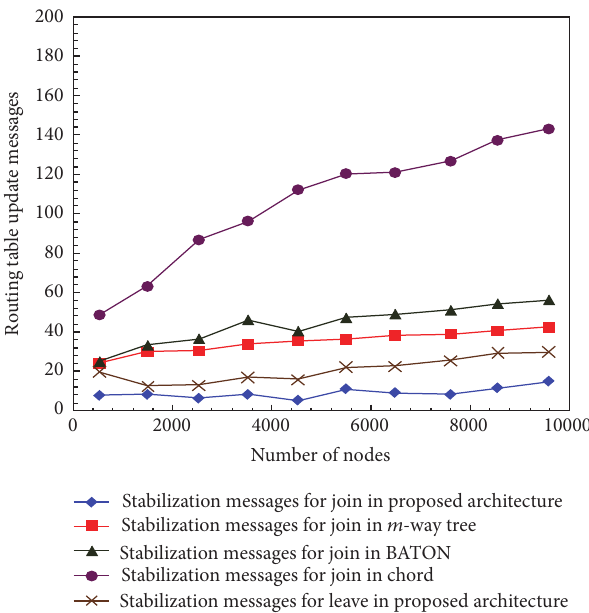
Figure 5: Average stabilization messages for single node